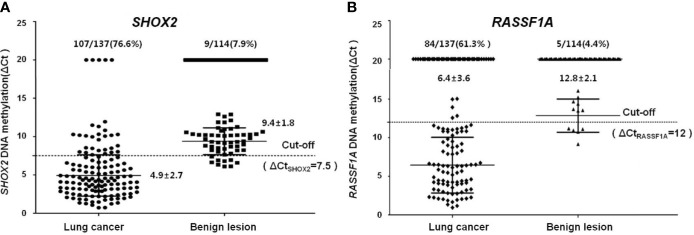
Quantitative analyzing of SHOX2
(A) and RASSF1A (B) DNA methylation in different histology groups (A). SHOX2 DNA methylation values measured in lung cancer (dots) and benign lesion (squares) (B). RASSF1A DNA methylation values measured in lung cancer (diamonds) and benign lesion (triangles).